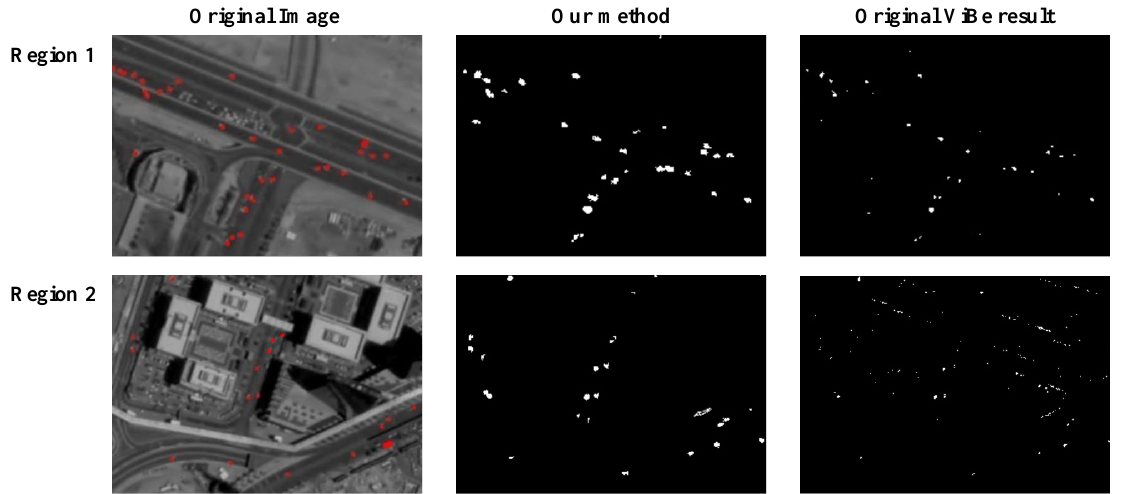
Figure 10. The comparison between grayscale image background and saliency based background. We select two regions in the original image. In each row of the figure, from left to right: the original image with manually marked ground truth in red, the saliency based detection result, and the grayscale image background